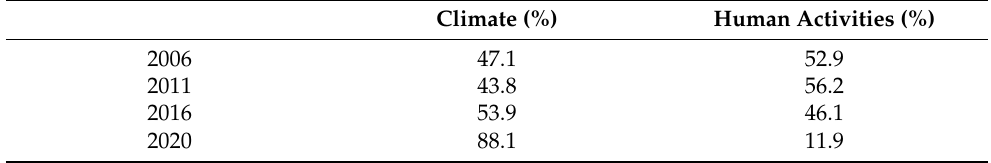
Table 2. Proportion of NPP that is induced by climate conditions and human